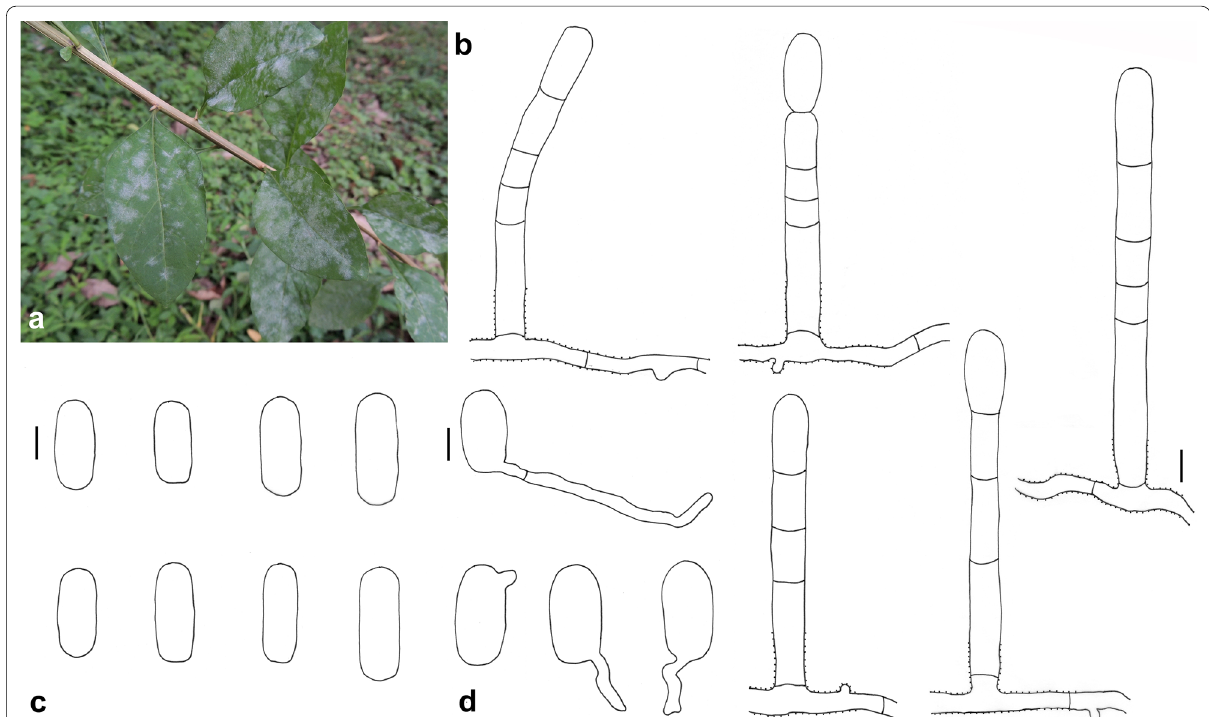
Fig. 2 Arthrocladiella mougeotii on Lycium chinense (AKII 0082, except in a . a Powdery mildew symptoms on leaves (Taipei, National Taiwan University campus, 23 April 2015). b Hyphae with nipple‑shaped appressoria and conidiophores. c Conidia. d Conidia with germination hyphae. Scale bars 10 =